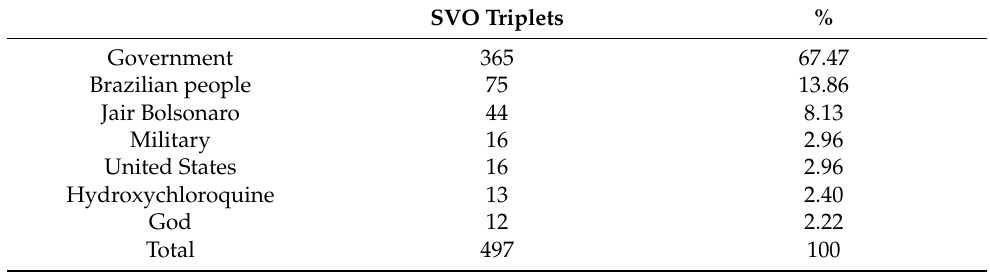
Table 13. Beatific dimension of fantasy in Bolsonaro’s Twitter discourse.